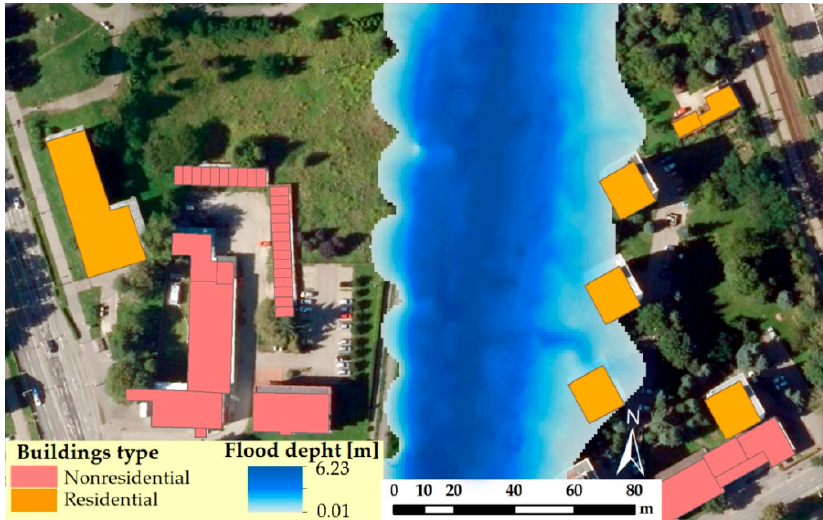
Figure 11. Example of hydrodynamic model generated for selected part of Prešov city: map showing maximum flow depths for level Q100.